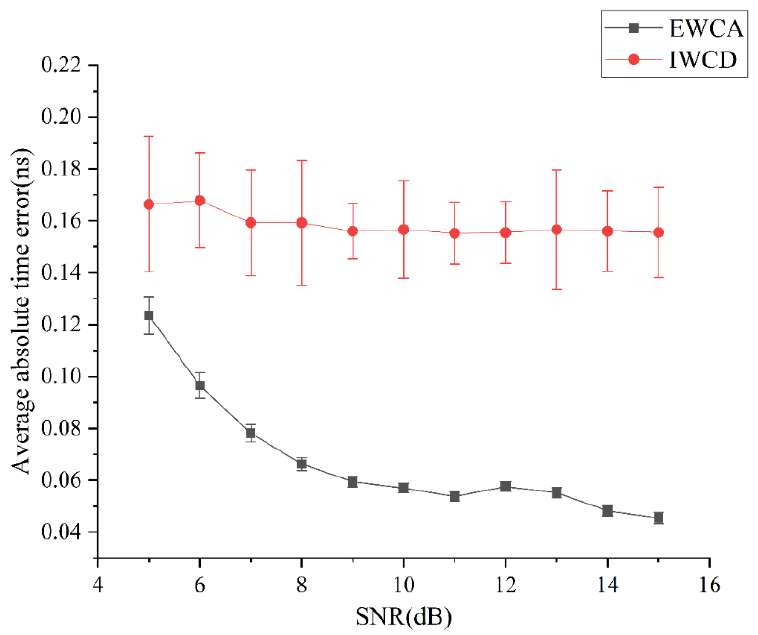
Figure 3. The error distribution diagram of the IWCD and EWCA under different SNR.